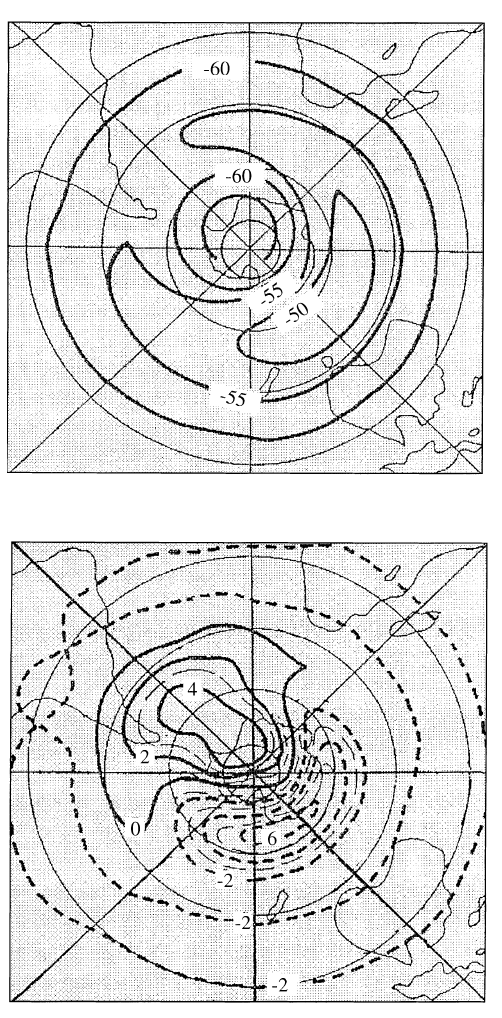
Fig. 2. 10-year mean of southern-hemisphere September, October, November (SON) time-average 50-hPa temperature field (1980–1989) from ECMWF analyses ( upper panel ). Southern-hemisphere SON time-average 50-hPa temperature di(cid:128)erences between the ECHAM3/ CHEM simulation and ECMWF analyses ( lower panel ). ECMWF data are subtracted from